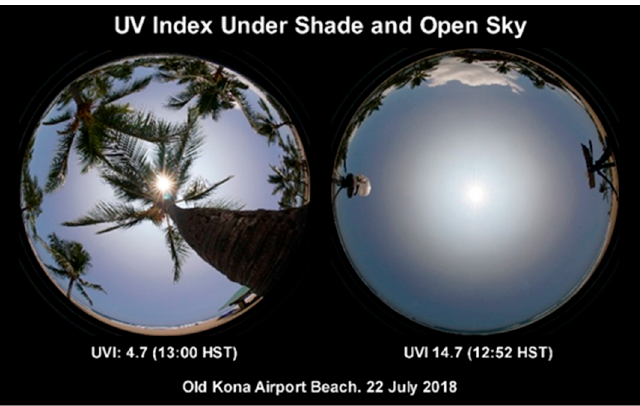
Figure 17. UVI in the shade of palm trees (4.7) and under an open sky (14.7) at the Old Kona Airport Park beach at near noon on 22 July 2018. The prominent solar aureole was caused by vog. A novel, low-cost UV camera [49] that could be fitted with various UVR filters was used to make several hundred UV photos of the mannequin head at the Old Kona Airport Park beach. The ozone column blocks virtually all sunlight below 295 nm. Thus, the UV camera’s spectral response with a